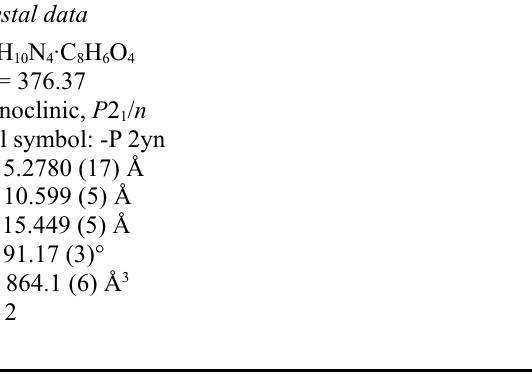
A three-dimensional view of the supramolecular layers of the title compound. 1,4-Bis(imidazol-1-yl)benzene–terephthalic acid